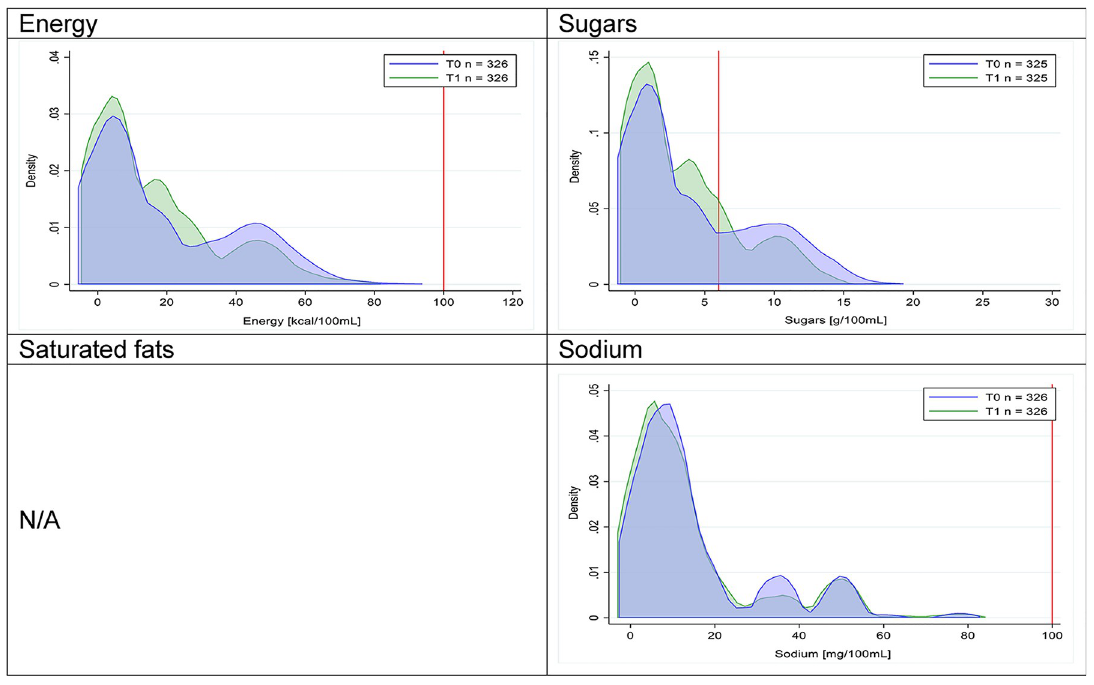
Fig 18. Density curves for the amount of energy and nutrients of concern in beverages, longitudinal subsample. The blue line represents the distribution in T0 (preimplementation), the green line represents the distribution in T1 (postimplementation), and the red line represents the cutoff for the amount of energy or nutrients of